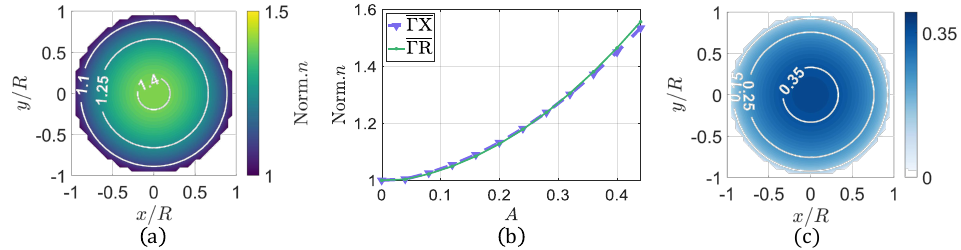
Figure 4. ( a ) Discretized refractive index of Lens. ( b ) Normalized effective refractive index as a function of A at 24GHz. ( c ) Synthesized dimensional map of the meta-lens.